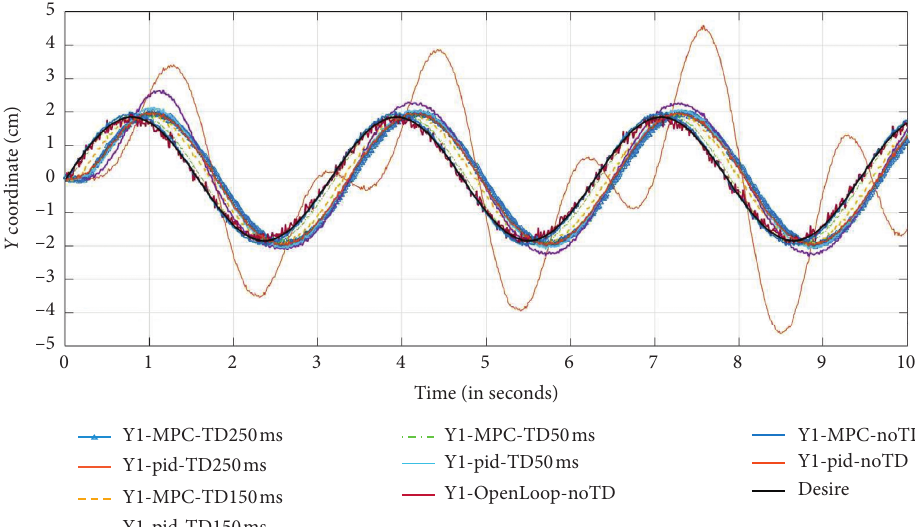
Figure 8: The performance of the Y -axis motion trajectory of block A under different delays and different